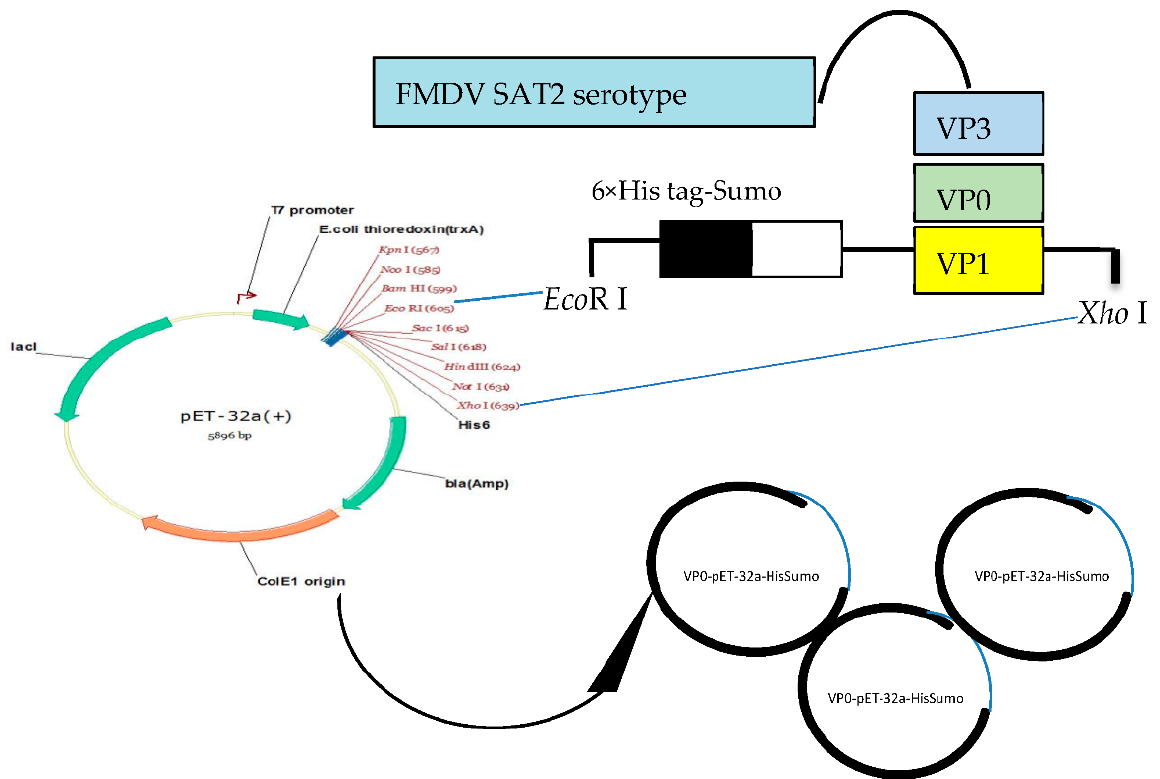
Figure 1. The construction of the His-SUMO fused three recombinant structural proteins of SAT2-FMDV serotype in pET-32a expression vector.